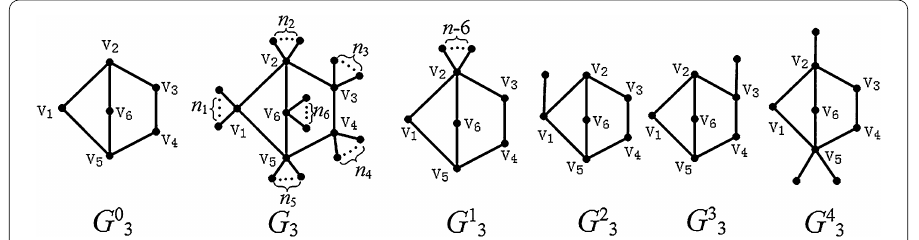
Figure 5 Some bicyclic graphs with θ (3,3,4) as their